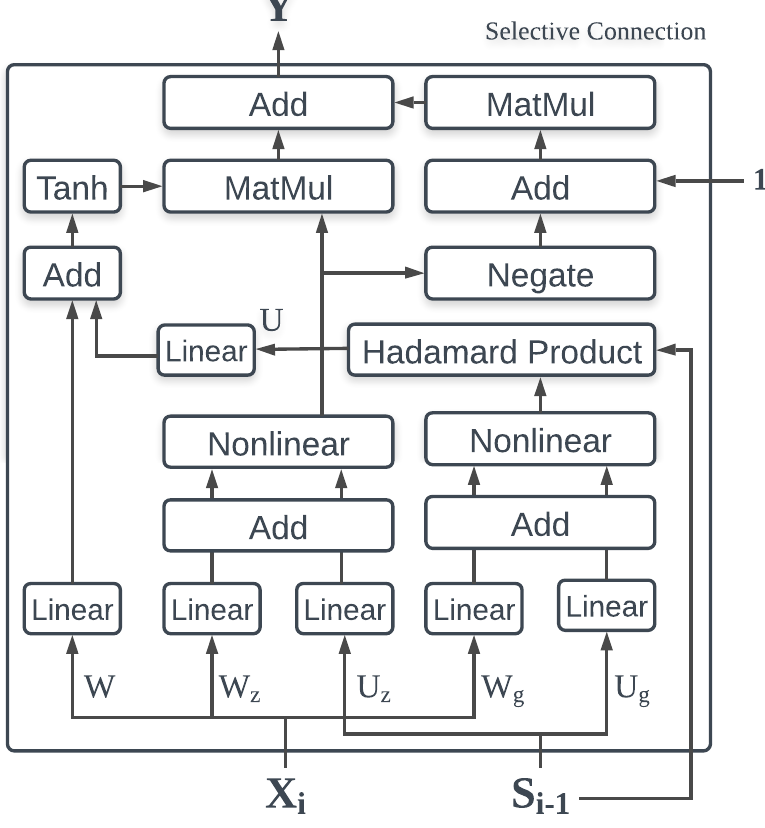
Figure 4. Overall